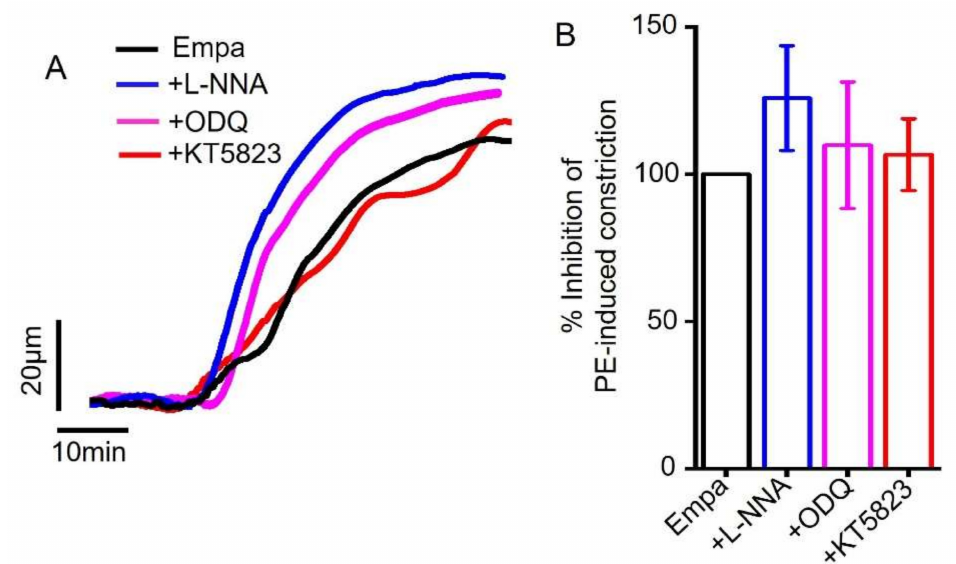
Figure 3. Empagliflozin-induced vasodilation in resistant mesenteric arteries is independent of NO- sGC-PKG signaling axis. ( A ) Original traces comparing empagliflozin (Empa)-induced vasodilation with or without pharmacological modulators (10 µ M L-NNA, 10 µ M ODQ and 1 µ M KT5823) of NO-sGC-PKG signaling axis. ( B ) Mean data comparing Empa-induced mesenteric artery vasodilation with or without pharmacological inhibitors of NO-sGC-PKG signaling, n =